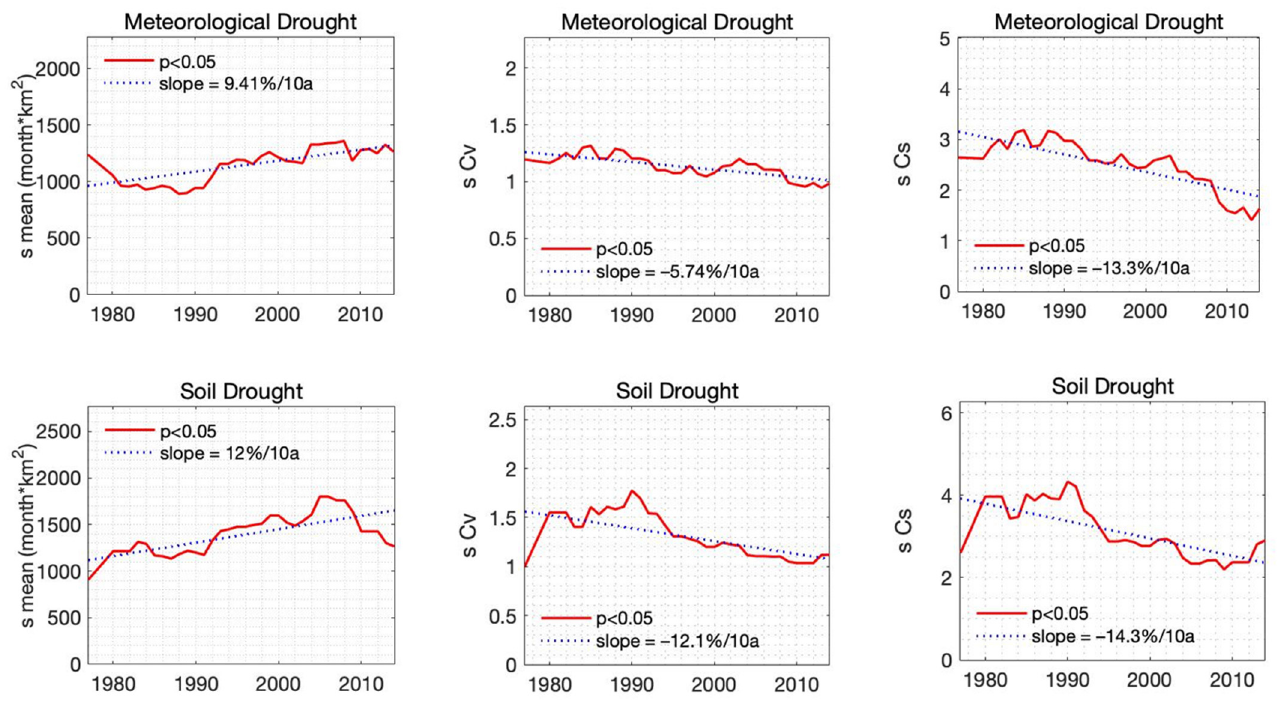
Figure 7. The change in the drought area distribution. a refers to the area ratio as Equation (2).